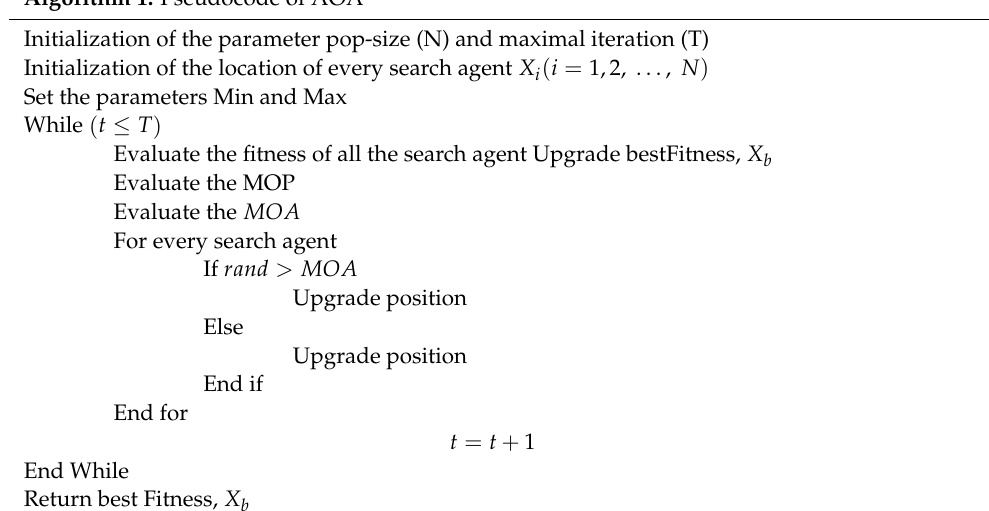
Algorithm 1. Pseudocode of